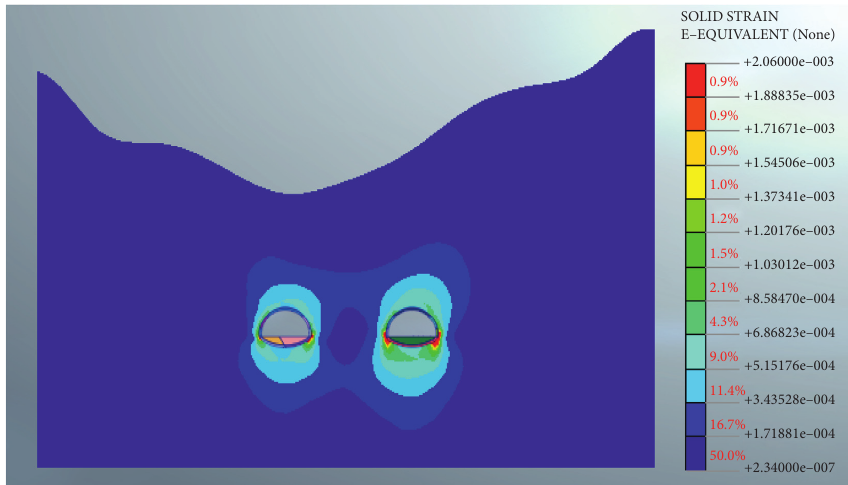
Figure 24: Plastic zone in three-step